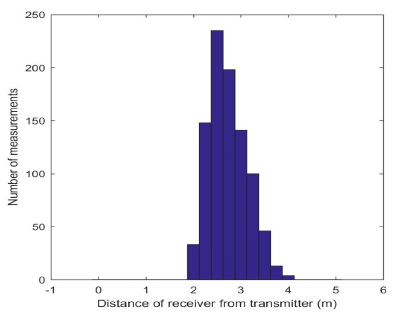
Figure 9. Linear range distribution of the ultrasonic sensors.